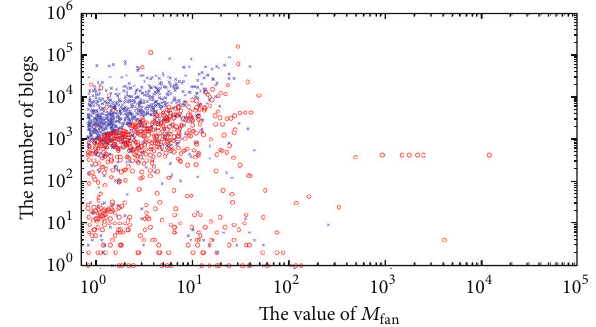
are arranged in top 1500; Blog